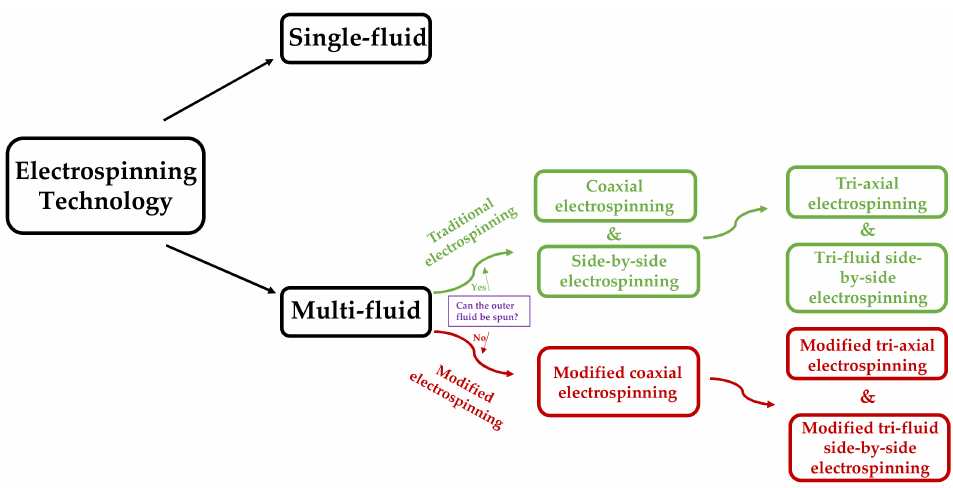
Figure 5. Classification of electrospinning